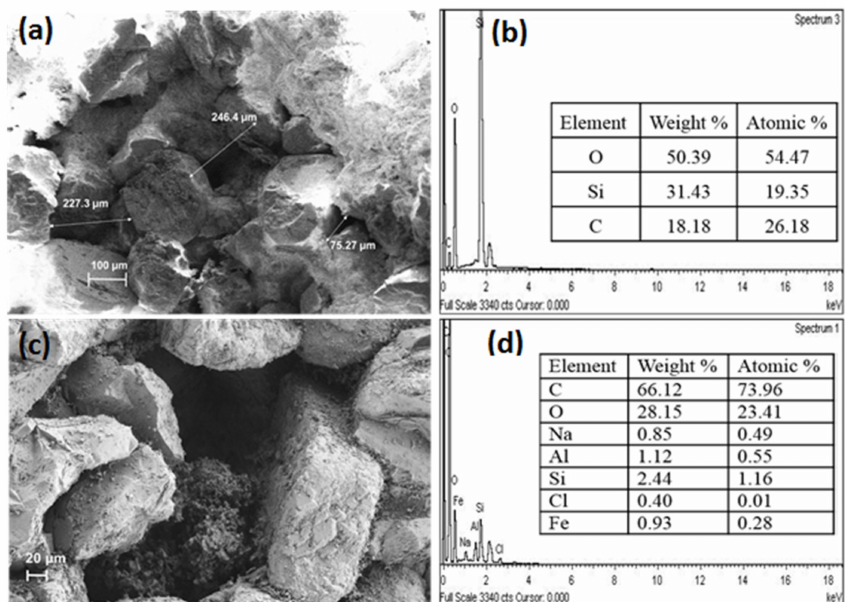
Figure 5. FESEM results showing ( a ) pore size distribution of the dry sandstone sample, ( b ) EDS analysis of element distribution of dry sandstone, ( c ) an image of a pore throat mapped after saturating with oil, brine and Fe 3 O 4 nanofluid and ( d ) EDS analysis of elemental distribution confirming the presence of the injected oil and nanofluid.